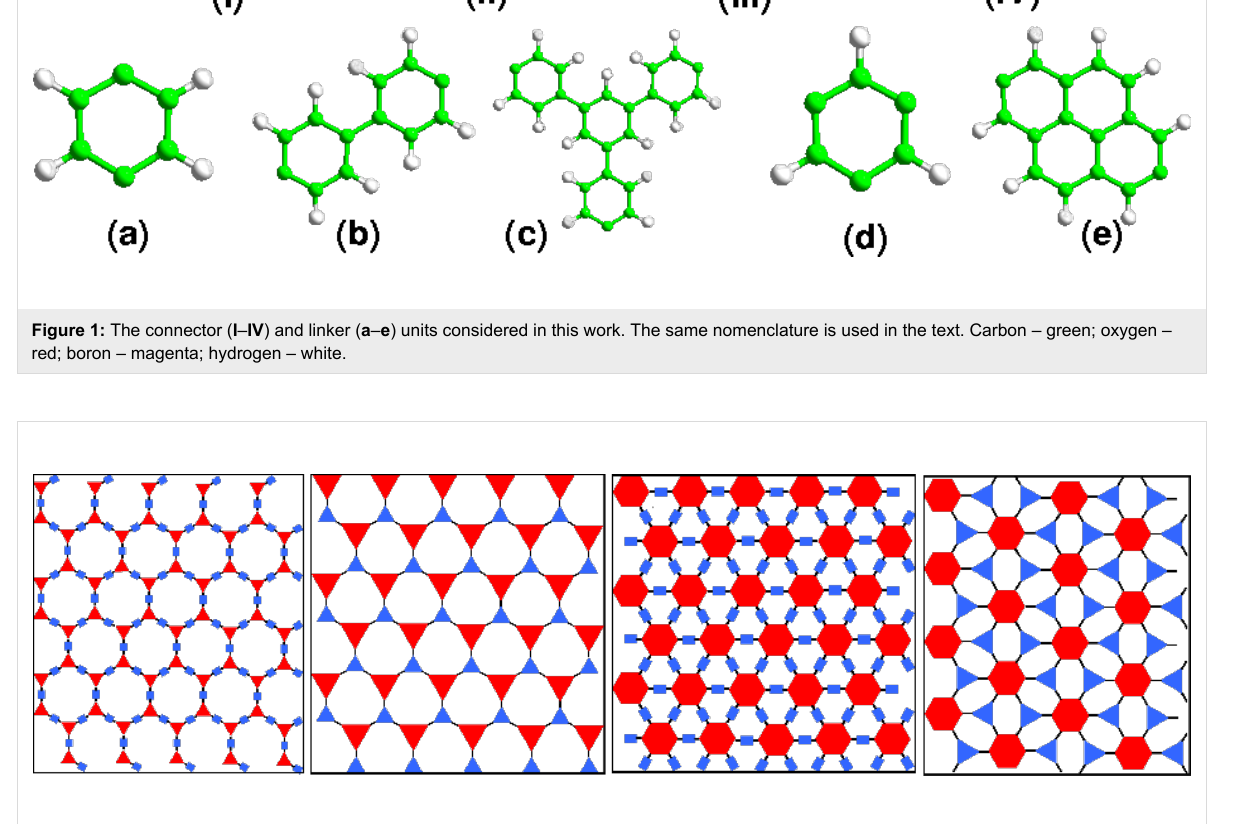
2D COFs [17]. As an example, the structure of COF-5 [7] in different kinds of stacking of layers is shown in Figure 3. In eclipsed AA stacking, atoms of adjacent layers lie directly on top of each other, whilst in staggered AB stacking, three- connected vertices lie directly on top of the geometric centre of six-membered rings of neighbouring layers. In both serrated and inclined kinds of stacking, the layers are shifted with respect to each other by approximately 1.4 Å, resulting in hexagonal rings in the connector or linker being staggered with those in the adjacent layers. In serrated stacking, alternate layers are eclipsed. In inclined stacking, layers lie shifted along one direction and the lattice vector pointing out of the 2D plane is not rectangular. For COFs made of connector I , due to the